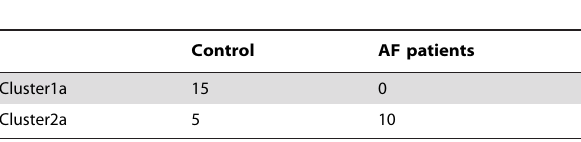
Table 1. Optimal cluster solution generated by OPC analysis on the U133A data set.